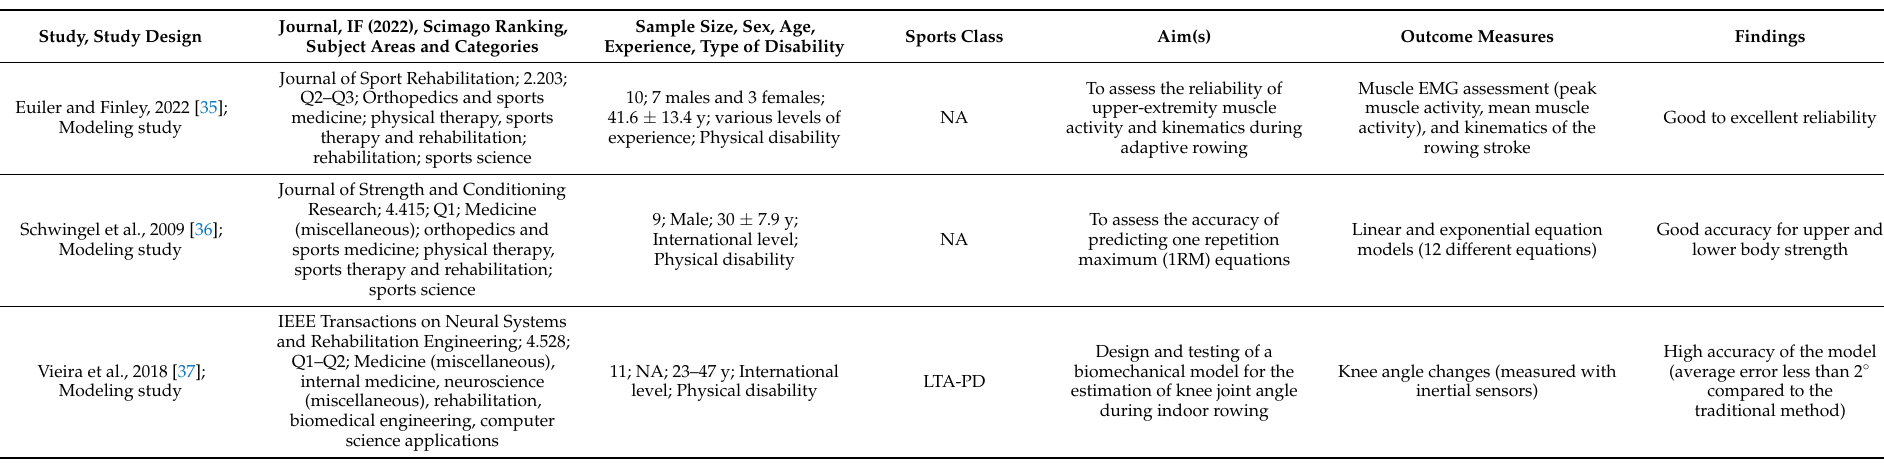
Table 4. Main characteristics of the study included in the present scoping review concerning emerging analytical approaches for kinematic assessments and predictions of mechanical outputs in para-rowing. Abbreviations: EMG (electromyography); IF (Impact Factor); NA (not available); y